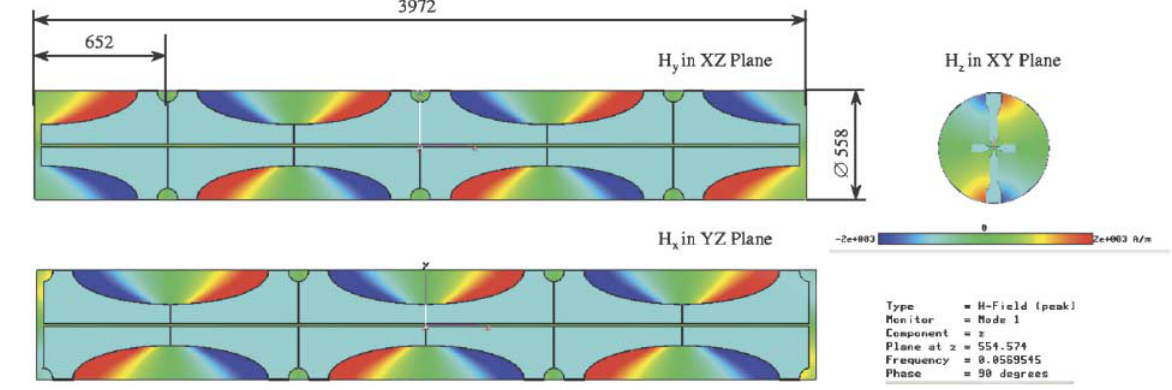
FIG. 12. (Color) Magnetic field density distribution in XZ , YZ , XY cross sections of the RFQ resonator.